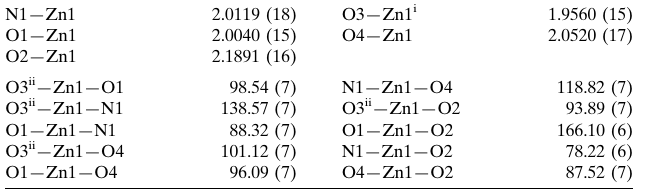
Selected geometric parameters (A˚ , (cid:1)